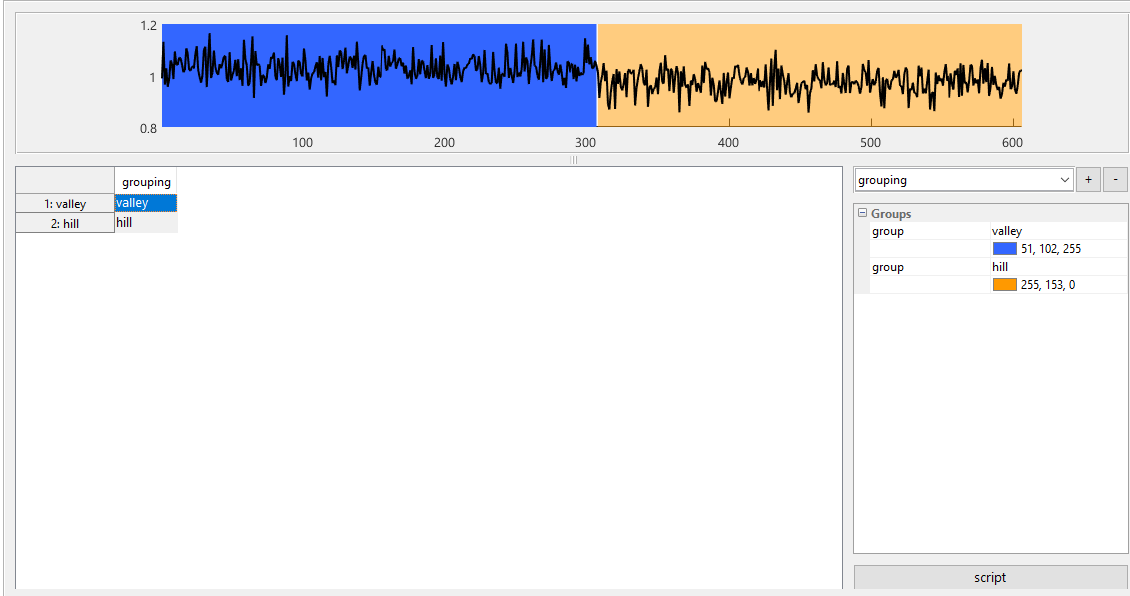
Figure 7. Grouping module which is used to assign classes to the previously selected ranges. An arbitrary number of grouping vectors can be created which can later be selected as target vectors during model training. The plot shows a graphical representation of the currently selected grouping to highlight errors and to show the structure of the data at one glance.